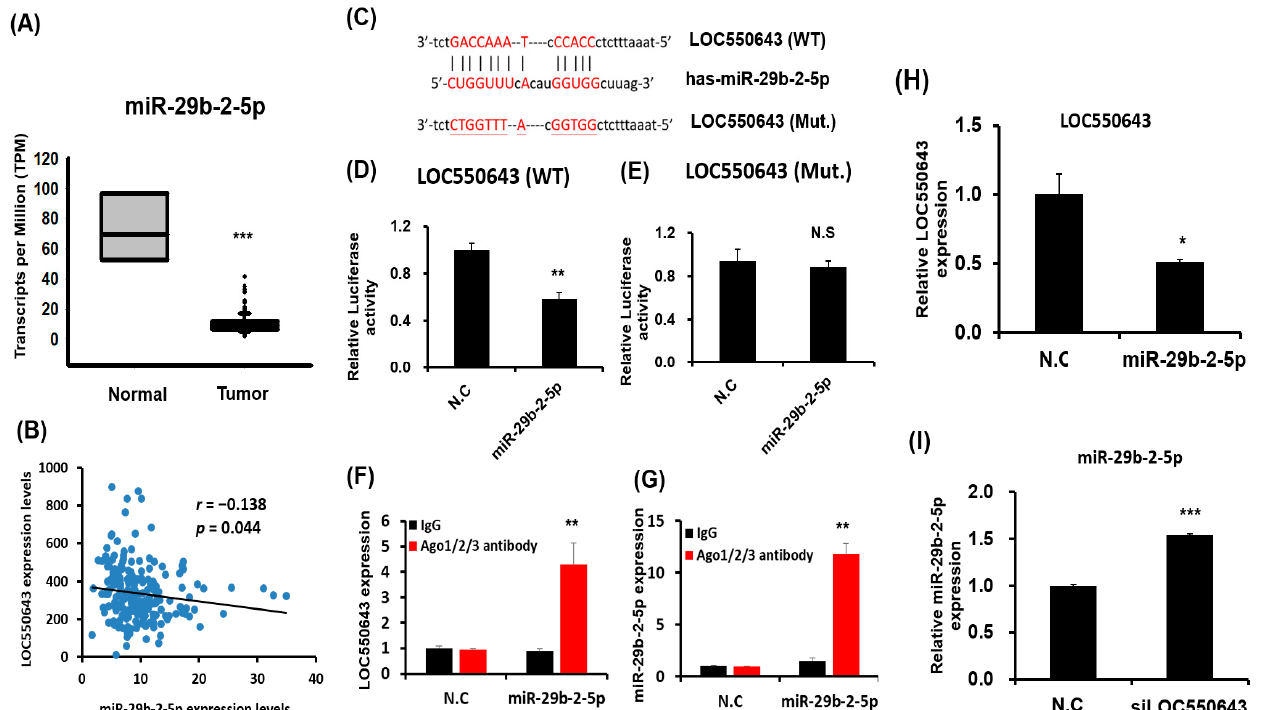
Figure 7. LOC550643 sponged miR-29b-2-5p expression through direct interaction. ( A ) MiR-29b-2-5p expression was examined in CRC cells through the analysis of the TCGA database. ( B ) The rela- tionship between LOC550643 and miR-29b-2-5p in CRC cells was assessed through Pearson corre- lation analysis. ( C ) Reporter construct sequences with wild-type LOC550643 or a binding site mu- tant is presented. ( D , E ) After miR-29b-2-5p cotransfection with pMIR-REPROT-LOC550643 or pMIR-REPROT-LOC550643 (mutant) into colon cancer cells, relative luciferase activity was assessed. Firefly luciferase activity served as a normalization control. ( F , G ) HCT116 cells were used to per- form Ago2 protein precipitation, and the expression levels of miR-29b-2-5p and LOC550643 were examined using real-time PCR. ( H ) Endogenous LOC550643 expression was examined in HCT116 cells transfected with miR-29b-2-5p mimics. ( I ) Endogenous miR-29b-2-5p expression was assessed in HCT116 cells with LOC550643 knockdown (* p < 0.05, ** p < 0.01, *** p < 0.001).